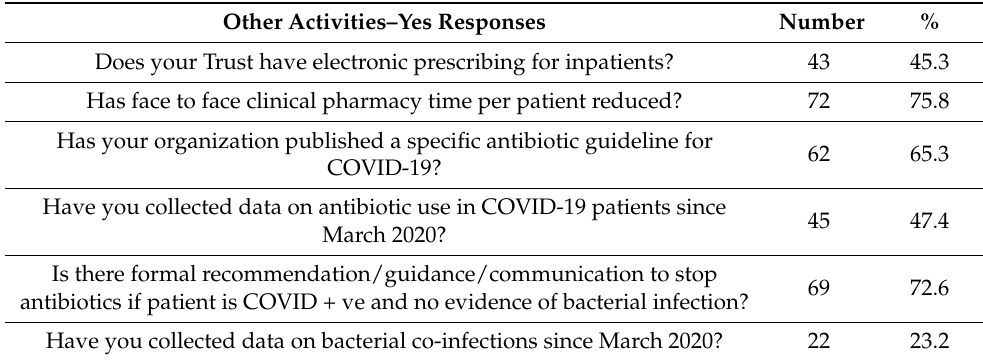
Figure 3. Percentage of organizations that reviewed their guidelines ( n = 95 respondents). Table 3. Other activities undertaken in organizations during the COVID-19 pandemic ( n = 95).